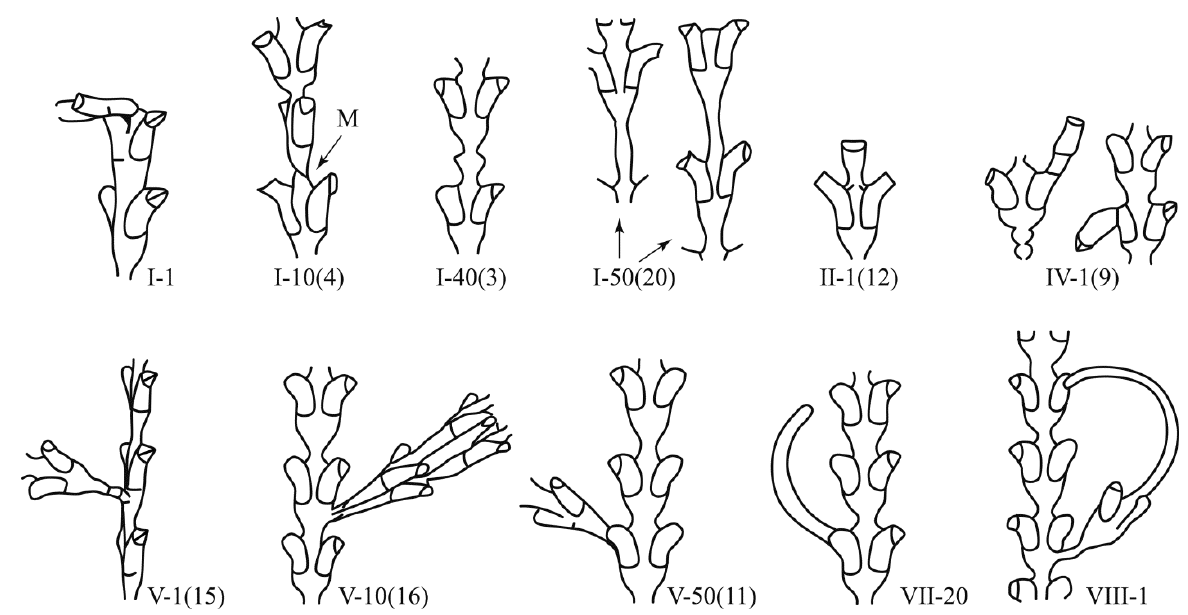
Figure 4. Variants of deviation from typical shoot morphogenesis of D. pumila . 1-10(4). The plane of the upper part of the shoot does not coincide with the lower (Figure 4). The turning point is a thin waist between the modules. Rotation can occur at different angles up to 90 ◦ . This morphovariation occurs after the suspension of growth and is often accompanied by the formation of an oblique constriction after the beginning of the next growth period. Normally, an oblique constriction is only formed at the shoot rudiment when it appears on the